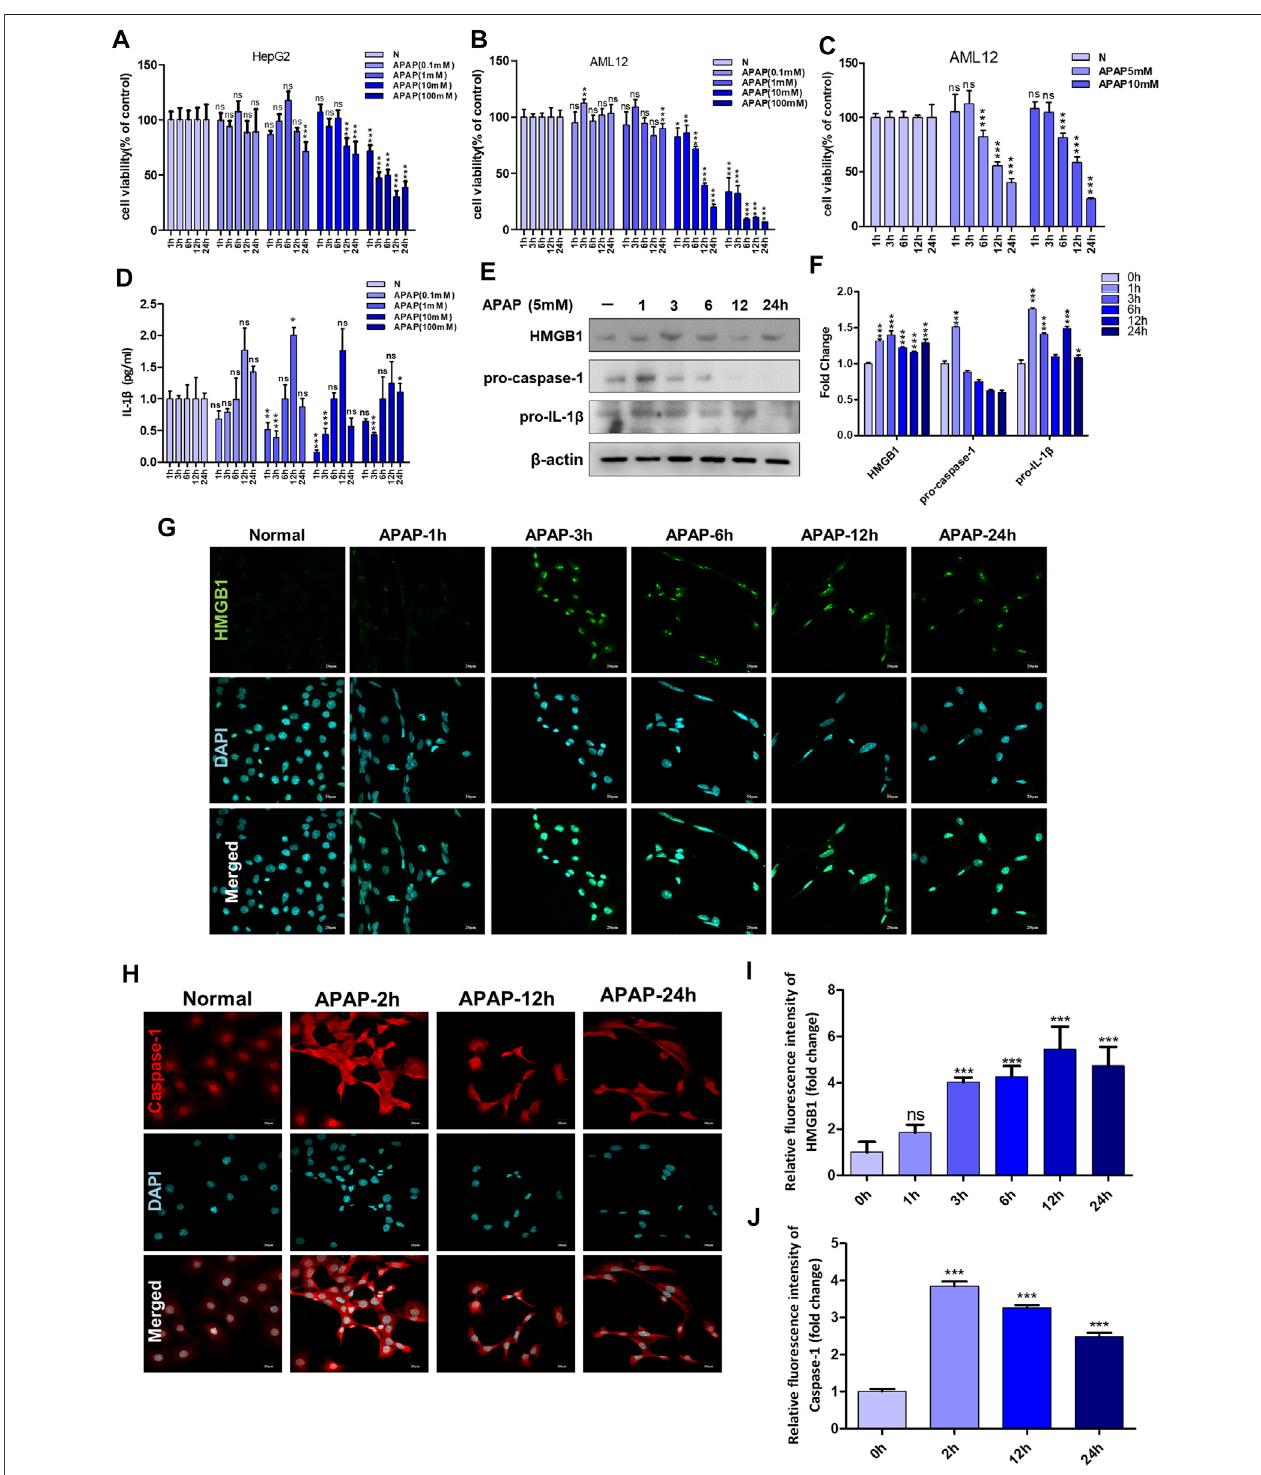
FIGURE1 | APAP in vitro experimental concentrationscreening and the in fl uence ofin fl ammation-related indicators after stimulatinghepatocytes. (A,B) The effect ofAPAPwithaconcentrationgradientof0 – 100 mMonthecytotoxicityofHepG2andAML12undera24 htimegradient. (C) ThecytotoxicityofAML12cellstreatedwith a time gradient of1 – 24 h at concentrations ofAPAP5 mM and 10 mM. (D) The level of IL-1 β in the supernatant of AML12 cells treated with 0 – 100 mM APAP for 1 – 24 h * p < 0.05, ** p < 0.01, *** p < 0.001, signi fi cantly different from 1 h group. (E,F) Treat AML12 cells with APAP (5 mM) under a time gradient of 0 – 24 h. The protein expression levels of HMGB1, pro-caspase-1 and pro-IL-1 β and the gray density relative to β -actin were analyzed. (G,H) Fluorescence expression of HMGB1 and